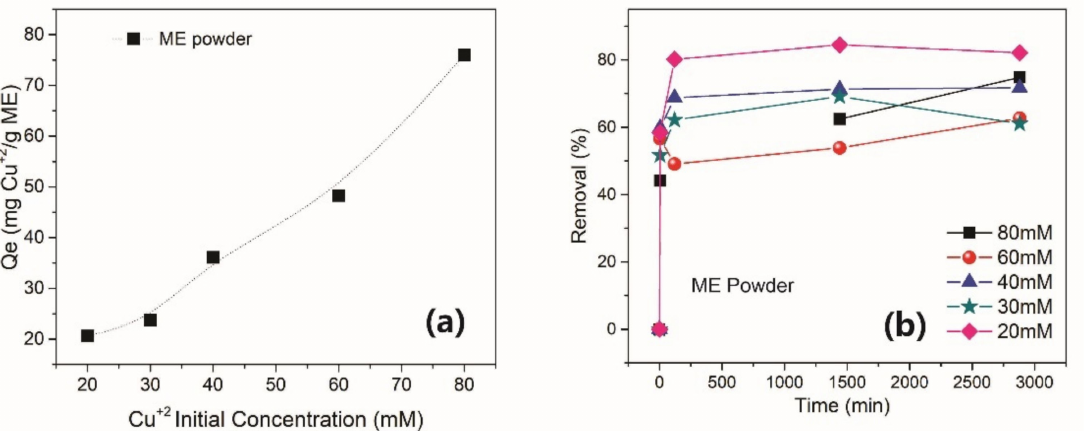
Figure 10. Adsorption behavior of ME powders: ( a ) Cu +2 adsorption isotherm ( b ) Removal % as a function of time for variable concentrations of Cu +2